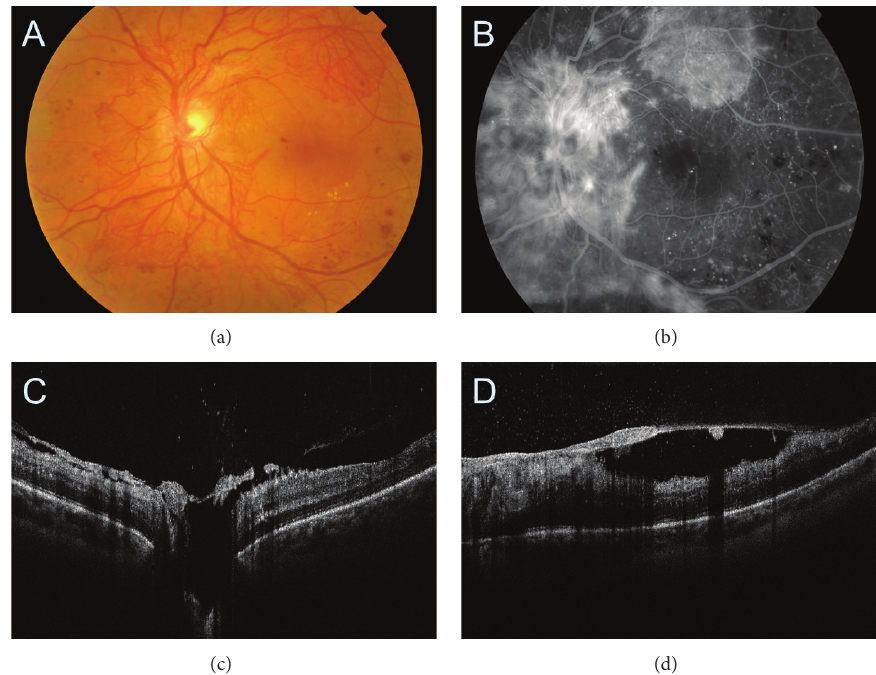
Figure 8: Proliferative diabetic retinopathy with neovascularization of the disc (NVD) and elsewhere (NVE). (a) Colour fundus photography. (b) Fluorescein angiography presenting an extensive leakage at the site of NVD and NVE. (c, d) SDOCT showing preretinal neovascular membrane at the disk and in the superior macula.